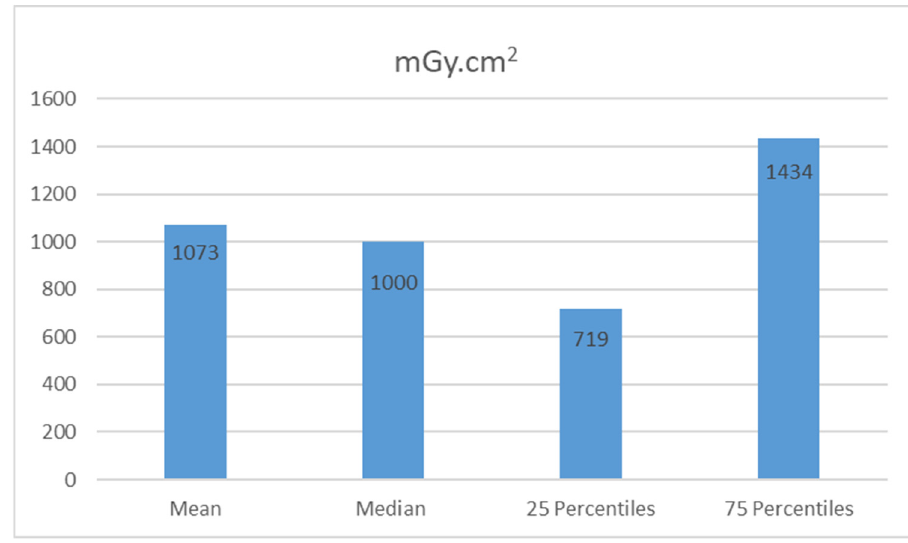
Figure 1. Patients’ dose (mode, median, range and percentile).